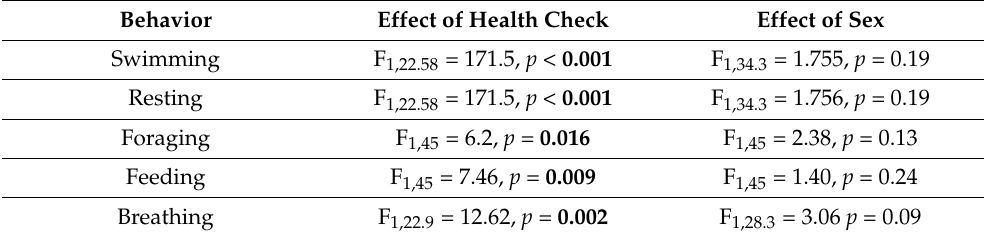
Table 3. Results of linear mixed models with health check and sex as explanatory variables. Significant p values are in bold.